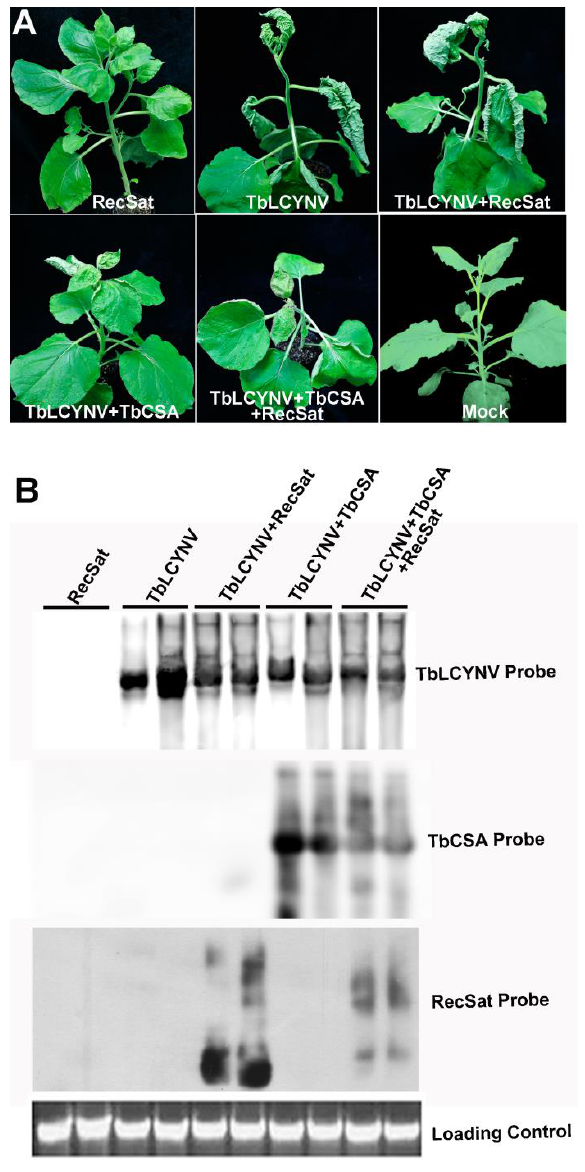
Figure 3. Effect of RecSat on the symptom development and DNA accumulation of helper virus. ( A ) Symptoms induced by TbLCYNV when co-inoculated with either RecSat or TbCSA/RecSat in Nicotiana benthamiana at 15 dpi. ( B ) Southern blot analysis